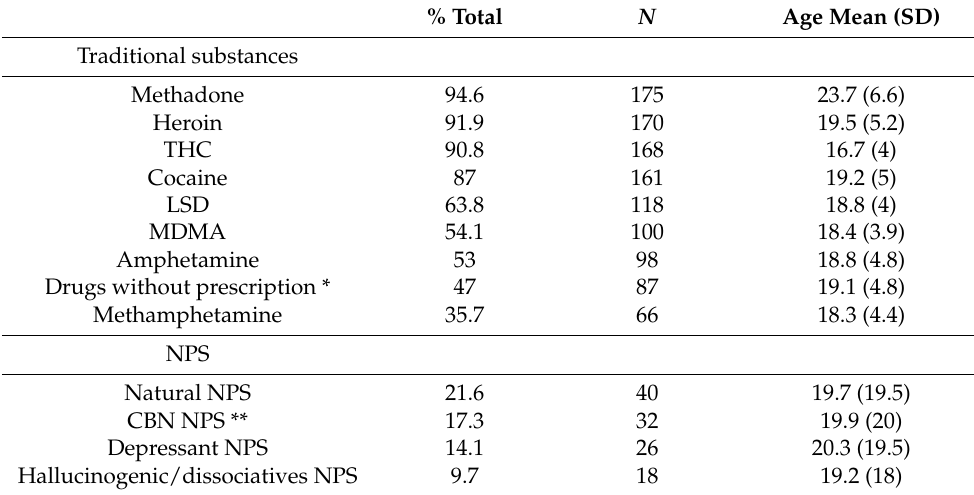
Table 3. Distribution and age of subjects using different